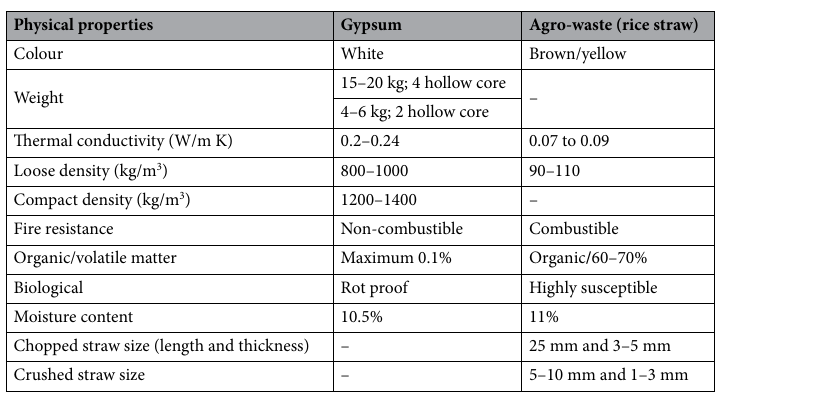
Table 1. Physical properties of rice straw and